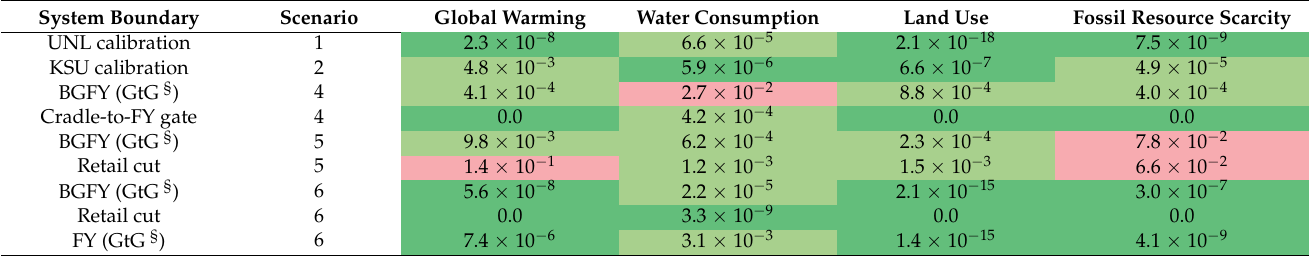
Table 8. Heatmap of Statistical Evaluation of Bootstrap Monte Carlo